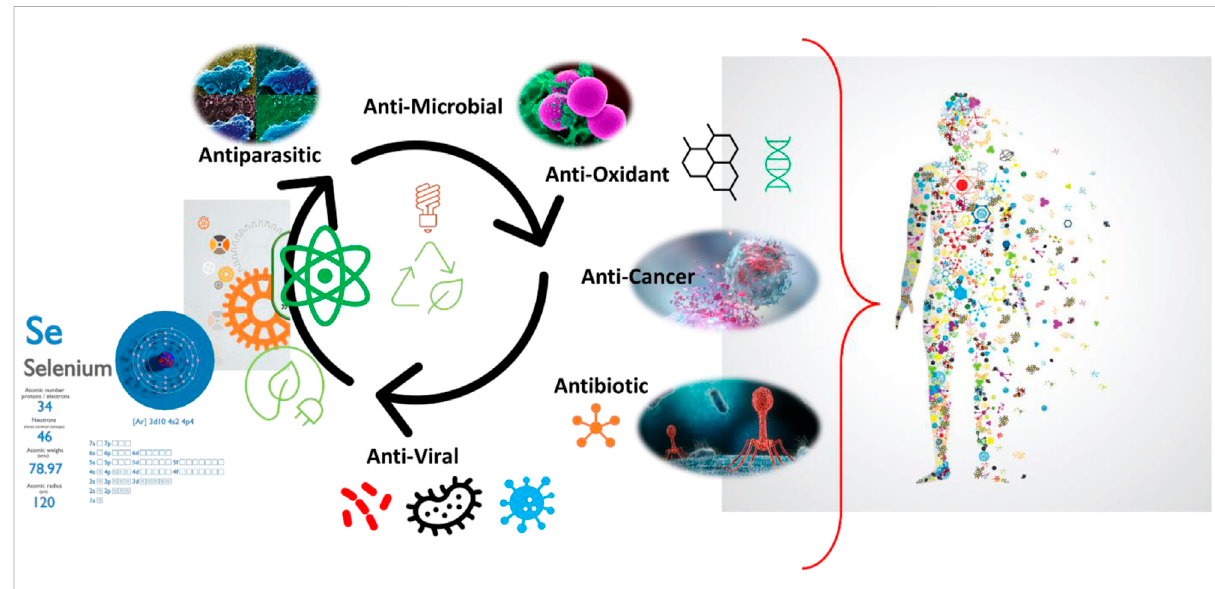
FIGURE 1 Biological activities of selenium nanoparticles (Nano-Se) and related systems.